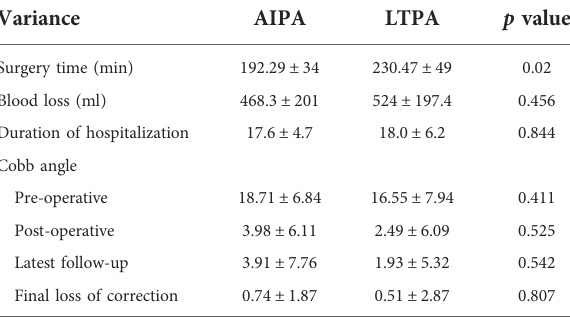
TABLE 2 Comparison of surgical outcomes between AIPA and LTPA groups.